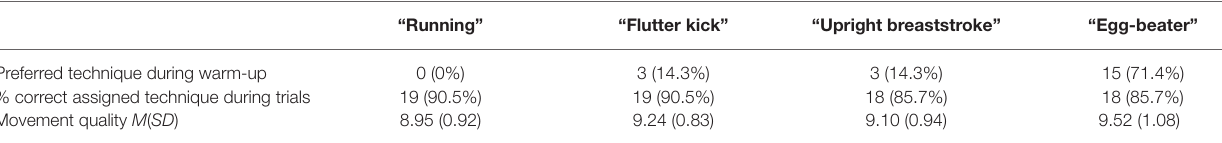
TABLE 2 | Preferred technique and quality of movement execution.